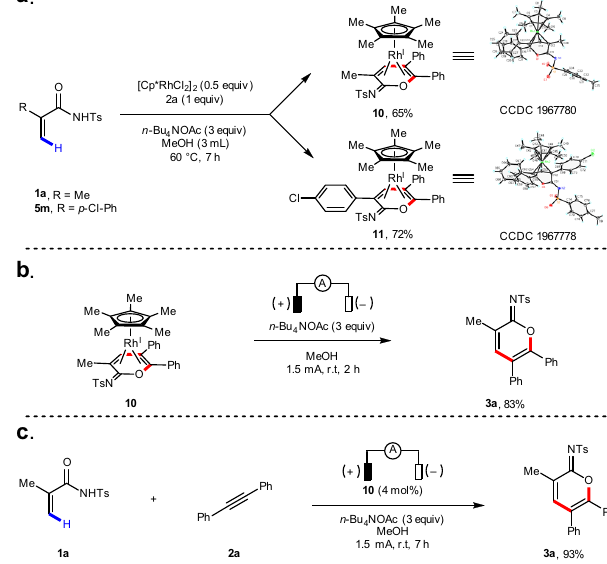
Fig. 5 Stoichiometric reaction. a Stoichiometric reactions in the absence of electric current. b Anodic oxidation of complex 10 . c Catalytic reaction with complex 10